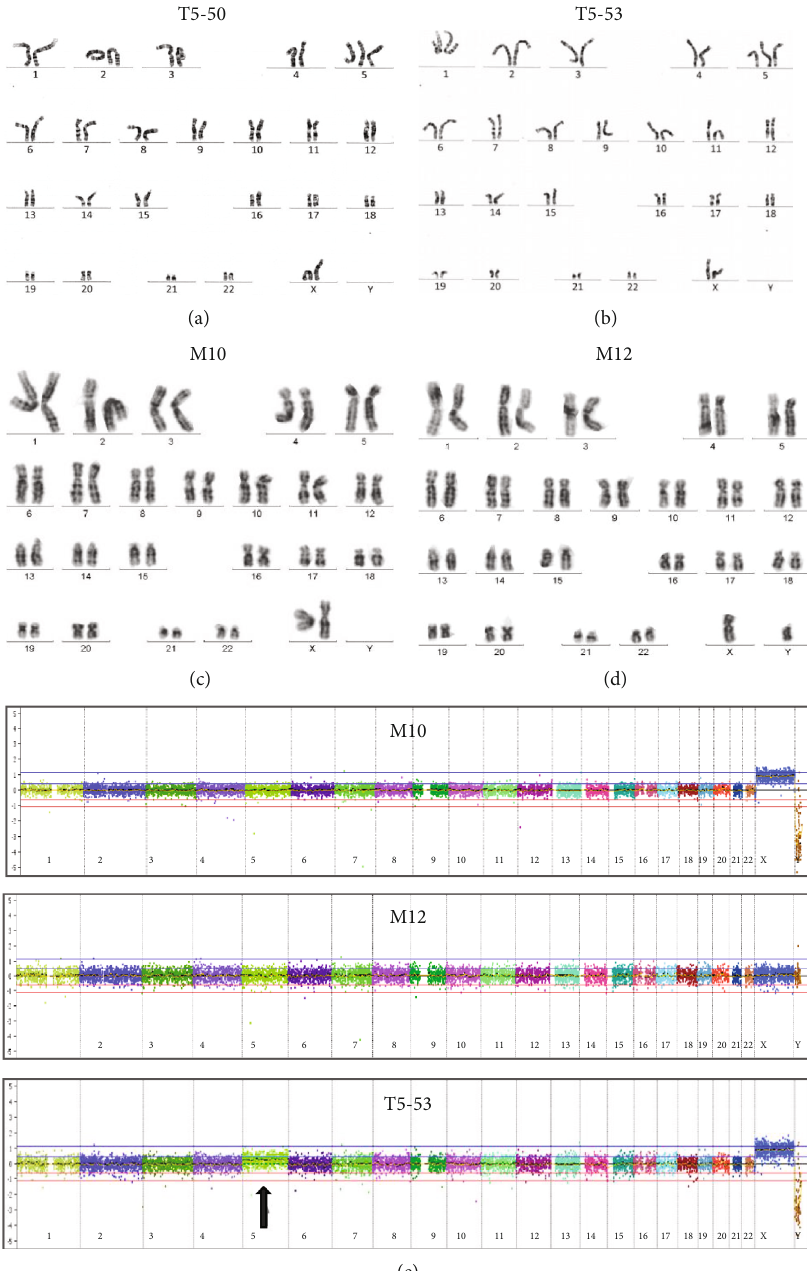
Figure 1: Cytogenetic characterization of distinct human MSC populations after ex vivo expansion. (a – d) Karyotyping results of the four investigated MSC cell lines. (a) MSC sample T5-50 karyotype 47,XX,+5. (b) MSC sample T5-53 karyotype 47,XX,+5. (c) MSC sample M10 karyotype 46,XX. (d) MSC sample M12 karyotype 46,XY. (e) CNV pro fi les of three MSC cell lines showing the results observed by CMA. Microarray probes are plotted along the X -axis according to their genomic coordinates and each color represents a chromosome (indicated below), from 1 to 22, X and Y (from the short to the long arm). The Y -axis represents the log 2 scale of the copy number ratio MSC cell lines/control (values close to 0 indicate regions with similar copy number between tested and control samples; positive values represent gains; negative values represent losses). The arrow shows the detected trisomy of chromosome 5 in